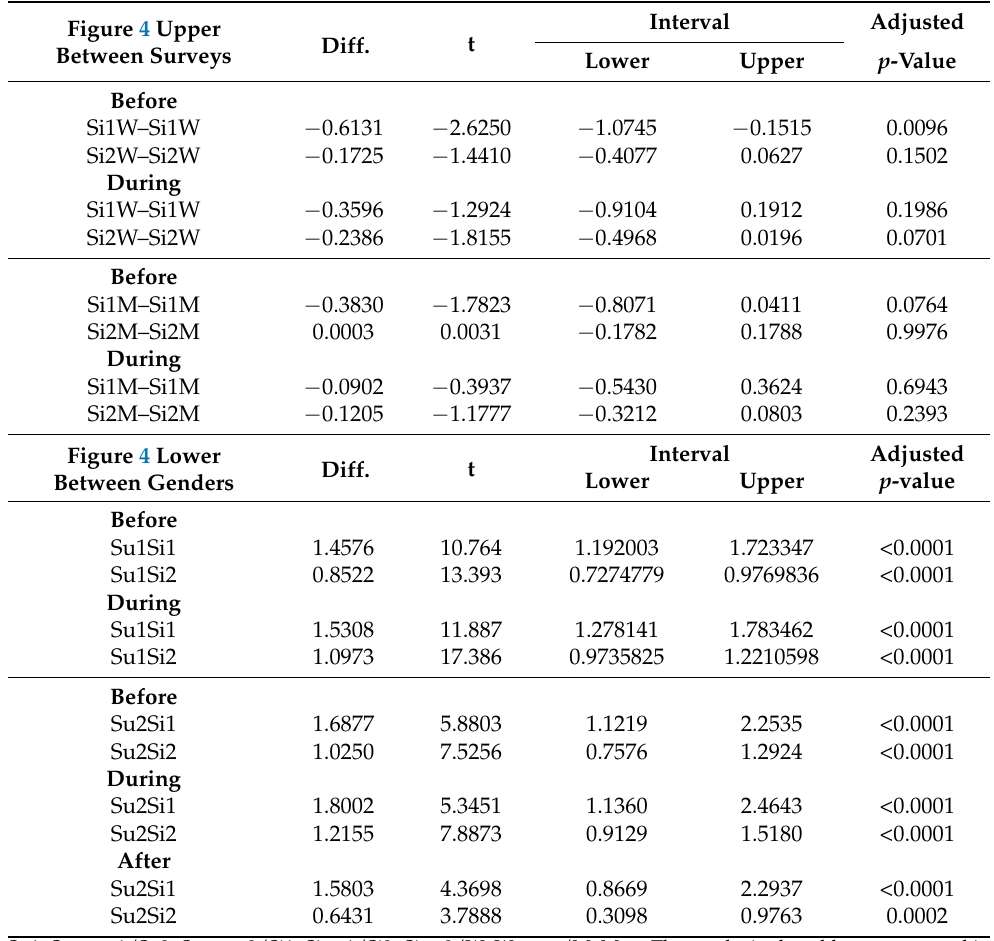
Table A2. Cont. Interval Adjusted Figure 3 Diff. t Between Municipalities Lower Upper p -Value During Su1Si1–Su1Si2 0.3296 Su2Si1–Su2Si2 After Su2Si1–Su2Si2 0.2412 1.1987 0.2316